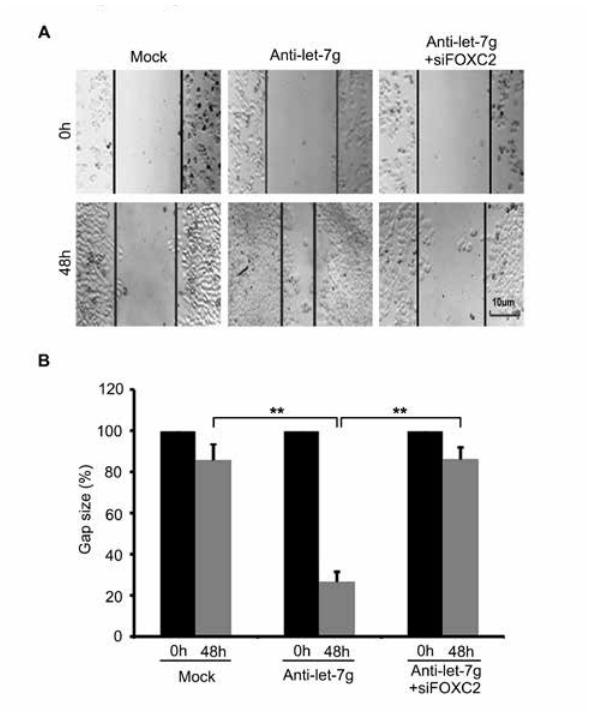
Figure 3: Let-7g reduces cell migration via FOXC2 in breast cancer. (A, B) Wound healing assays for anti-let-7g (or anti-let-7g/siFOXC2) effect on cell migration was performed in SK-BR3 cells. Scale bar = 10 μm. (Statistical differences: ** P < 0.01; Student’s t